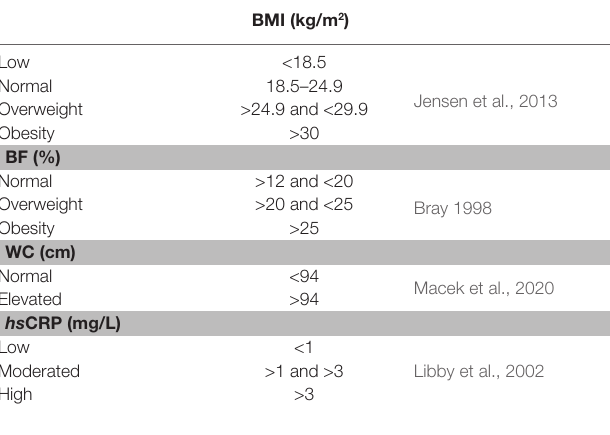
TABLE 1 | Reference values and classification criteria of cardiovascular